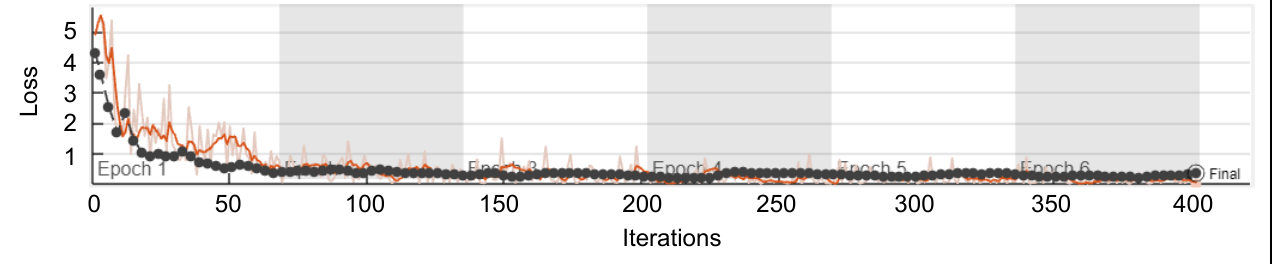
Figure 15. Loss versus iteration graph for Buttercup